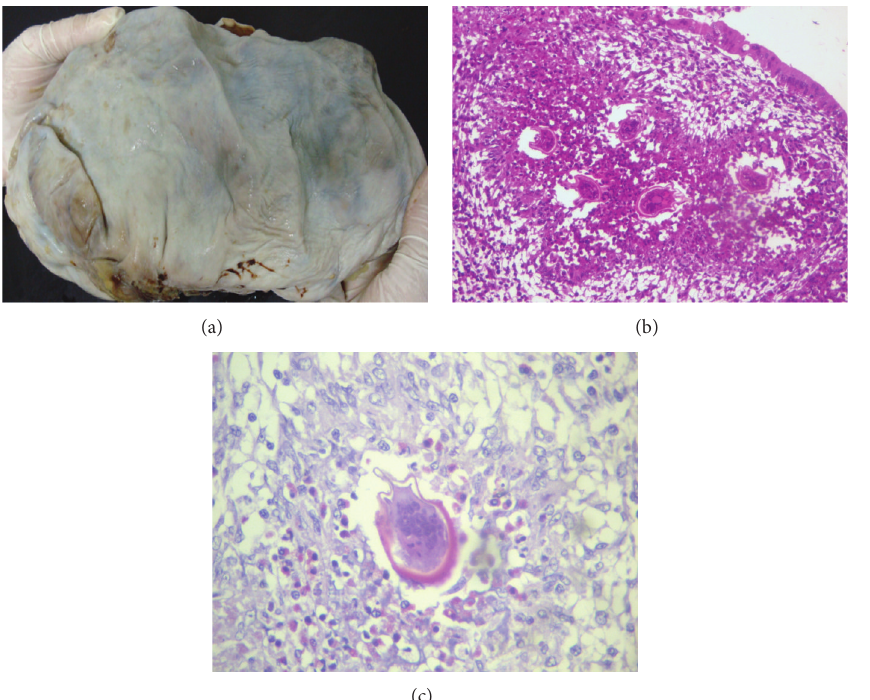
Figure 1: Case report #1. (a) Macroscopic view of the left ovary measuring 25 × 20 × 8 cm. (b) Viable S. mansoni eggs (hematoxylin-eosin, magnification 40x). (c) Detailed view of a S. mansoni egg (periodic acid-Schiff, magnification